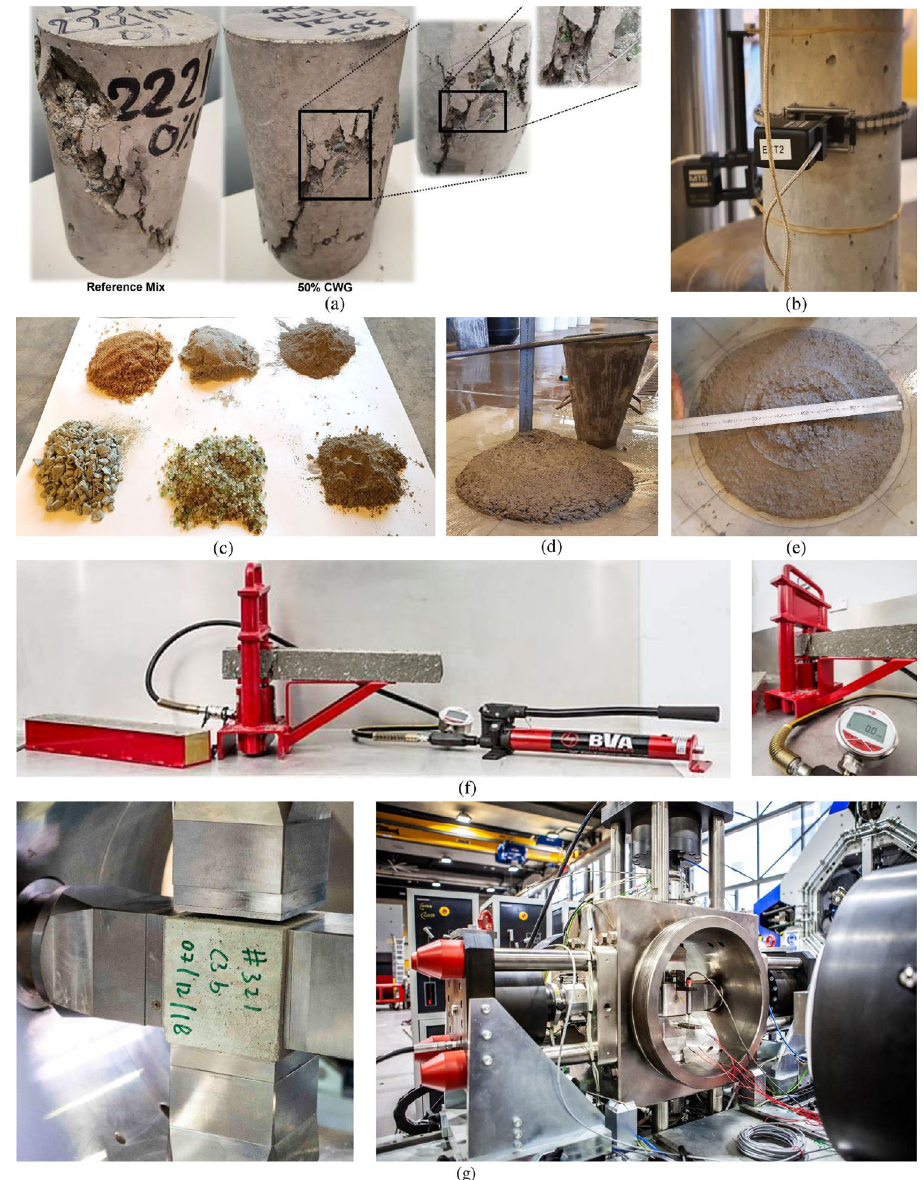
Fig. 1 Test results and the raw materials used in this research project, including a tested UCS samples at 0% and 50% sand replacement ratios, b instal- lation of vertical and radial extensometers to measure the shotcrete stiffness and radial expansion, c aggregates and binders, d slump test to meas- ure workability, e reverse cone test to measure pumpability, f end-beam test to assess shotcrete early-age strength, and g the experimental set-up for testing the samples under biaxial